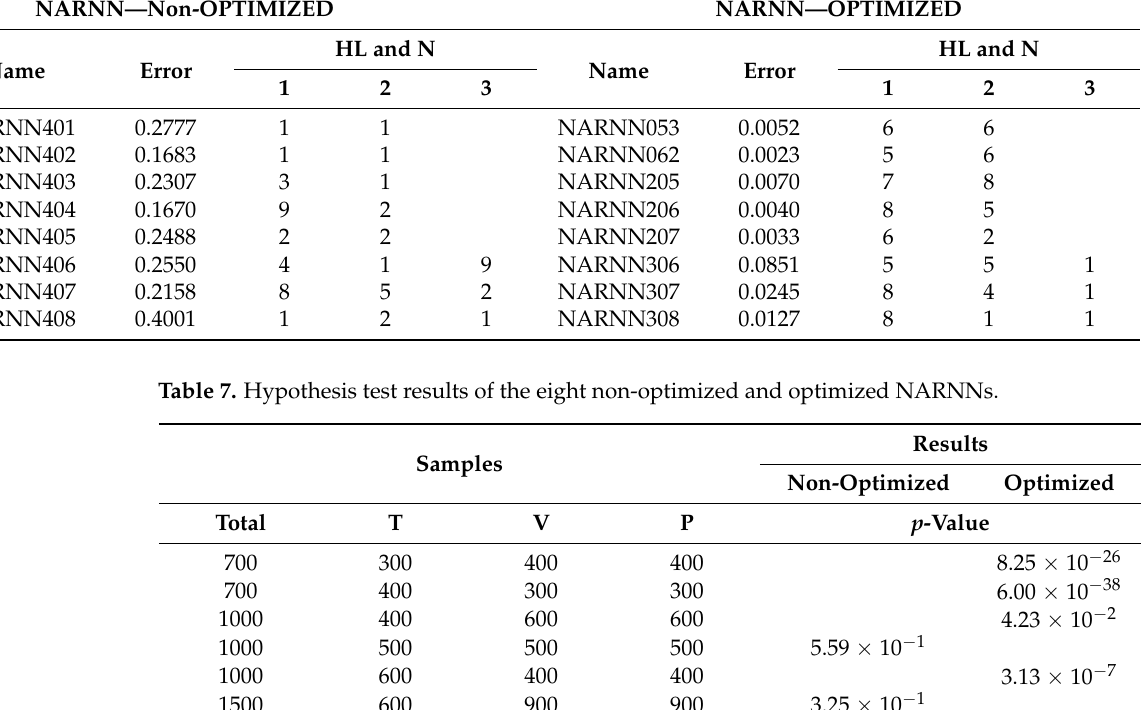
Table 6. Data for the eight non-optimized and optimized architectures.